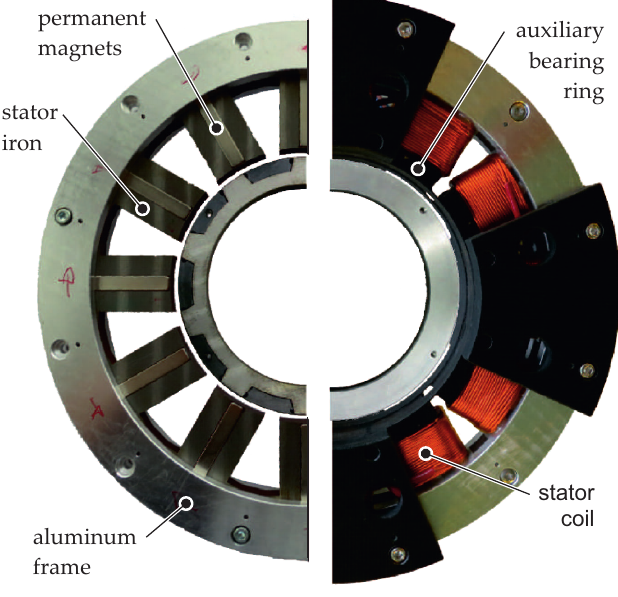
Figure 12. Photograph of the bearingless flux-switching motor